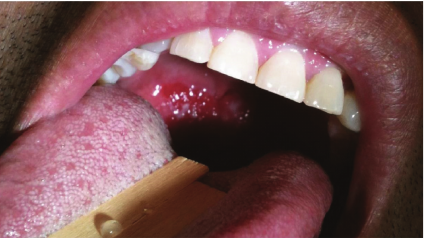
Figure 1: Erythematous tissue with white exudates covering the